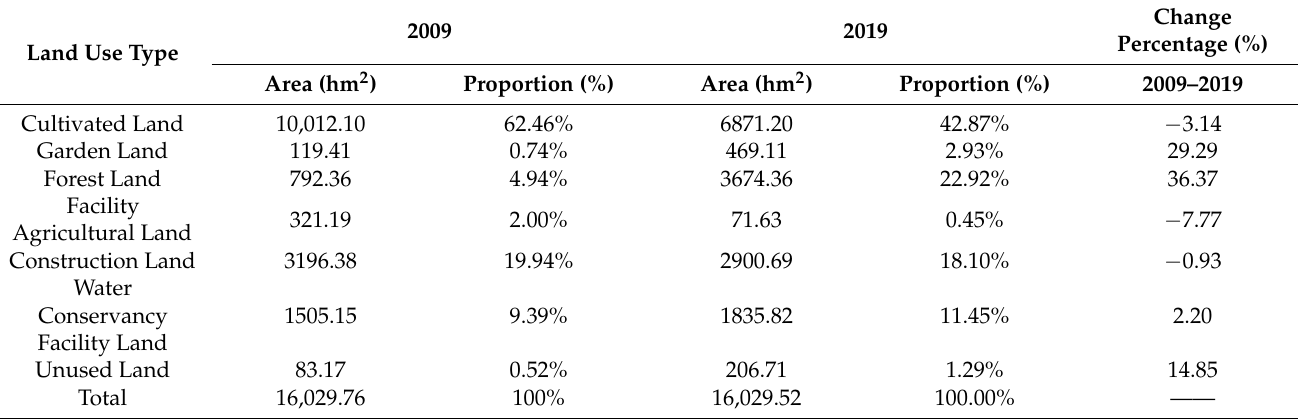
Table 1. LUC within the ecological corridors of the Shanghai Jinshan District from 2009 to